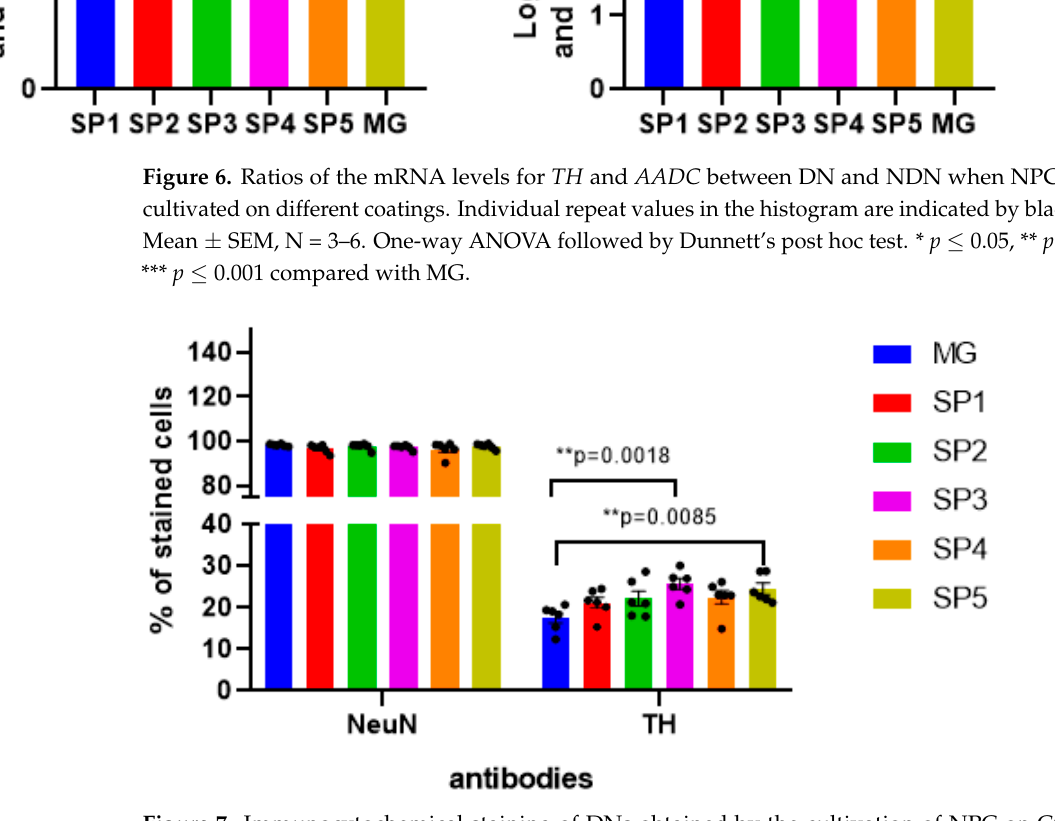
Figure 6. Ratios of the mRNA levels for TH and AADC between DN and NDN when NPCs were cultivated on different coatings. Individual repeat values in the histogram are indicated by black dots. Mean ± SEM, N = 3–6. One-way ANOVA followed by Dunnett’s post hoc test. * p ≤ 0.05, ** p ≤ 0.01, *** p ≤ 0.001 compared with MG.